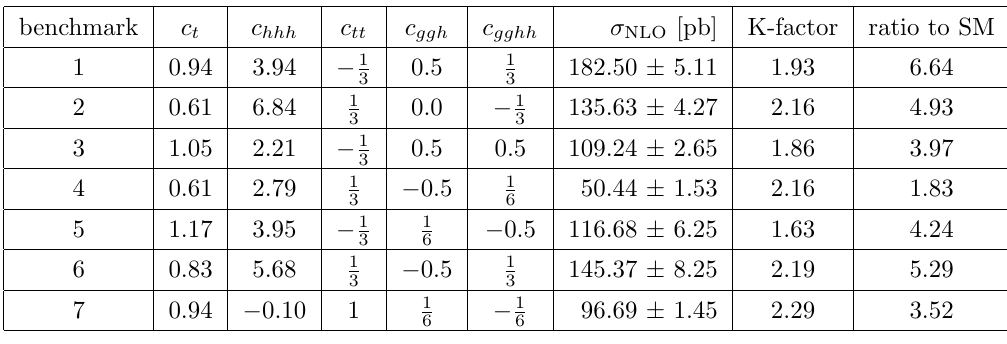
Table 2 . NLO benchmark points derived from the cluster centers as described in the text.